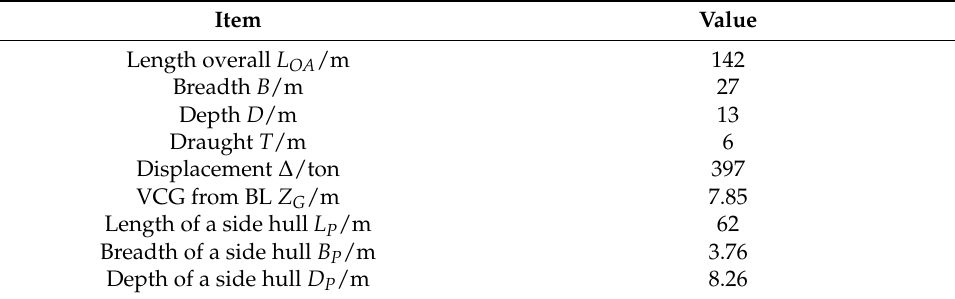
Figure 1. Overview of the trimaran. Table 1. Main particulars of the trimaran.